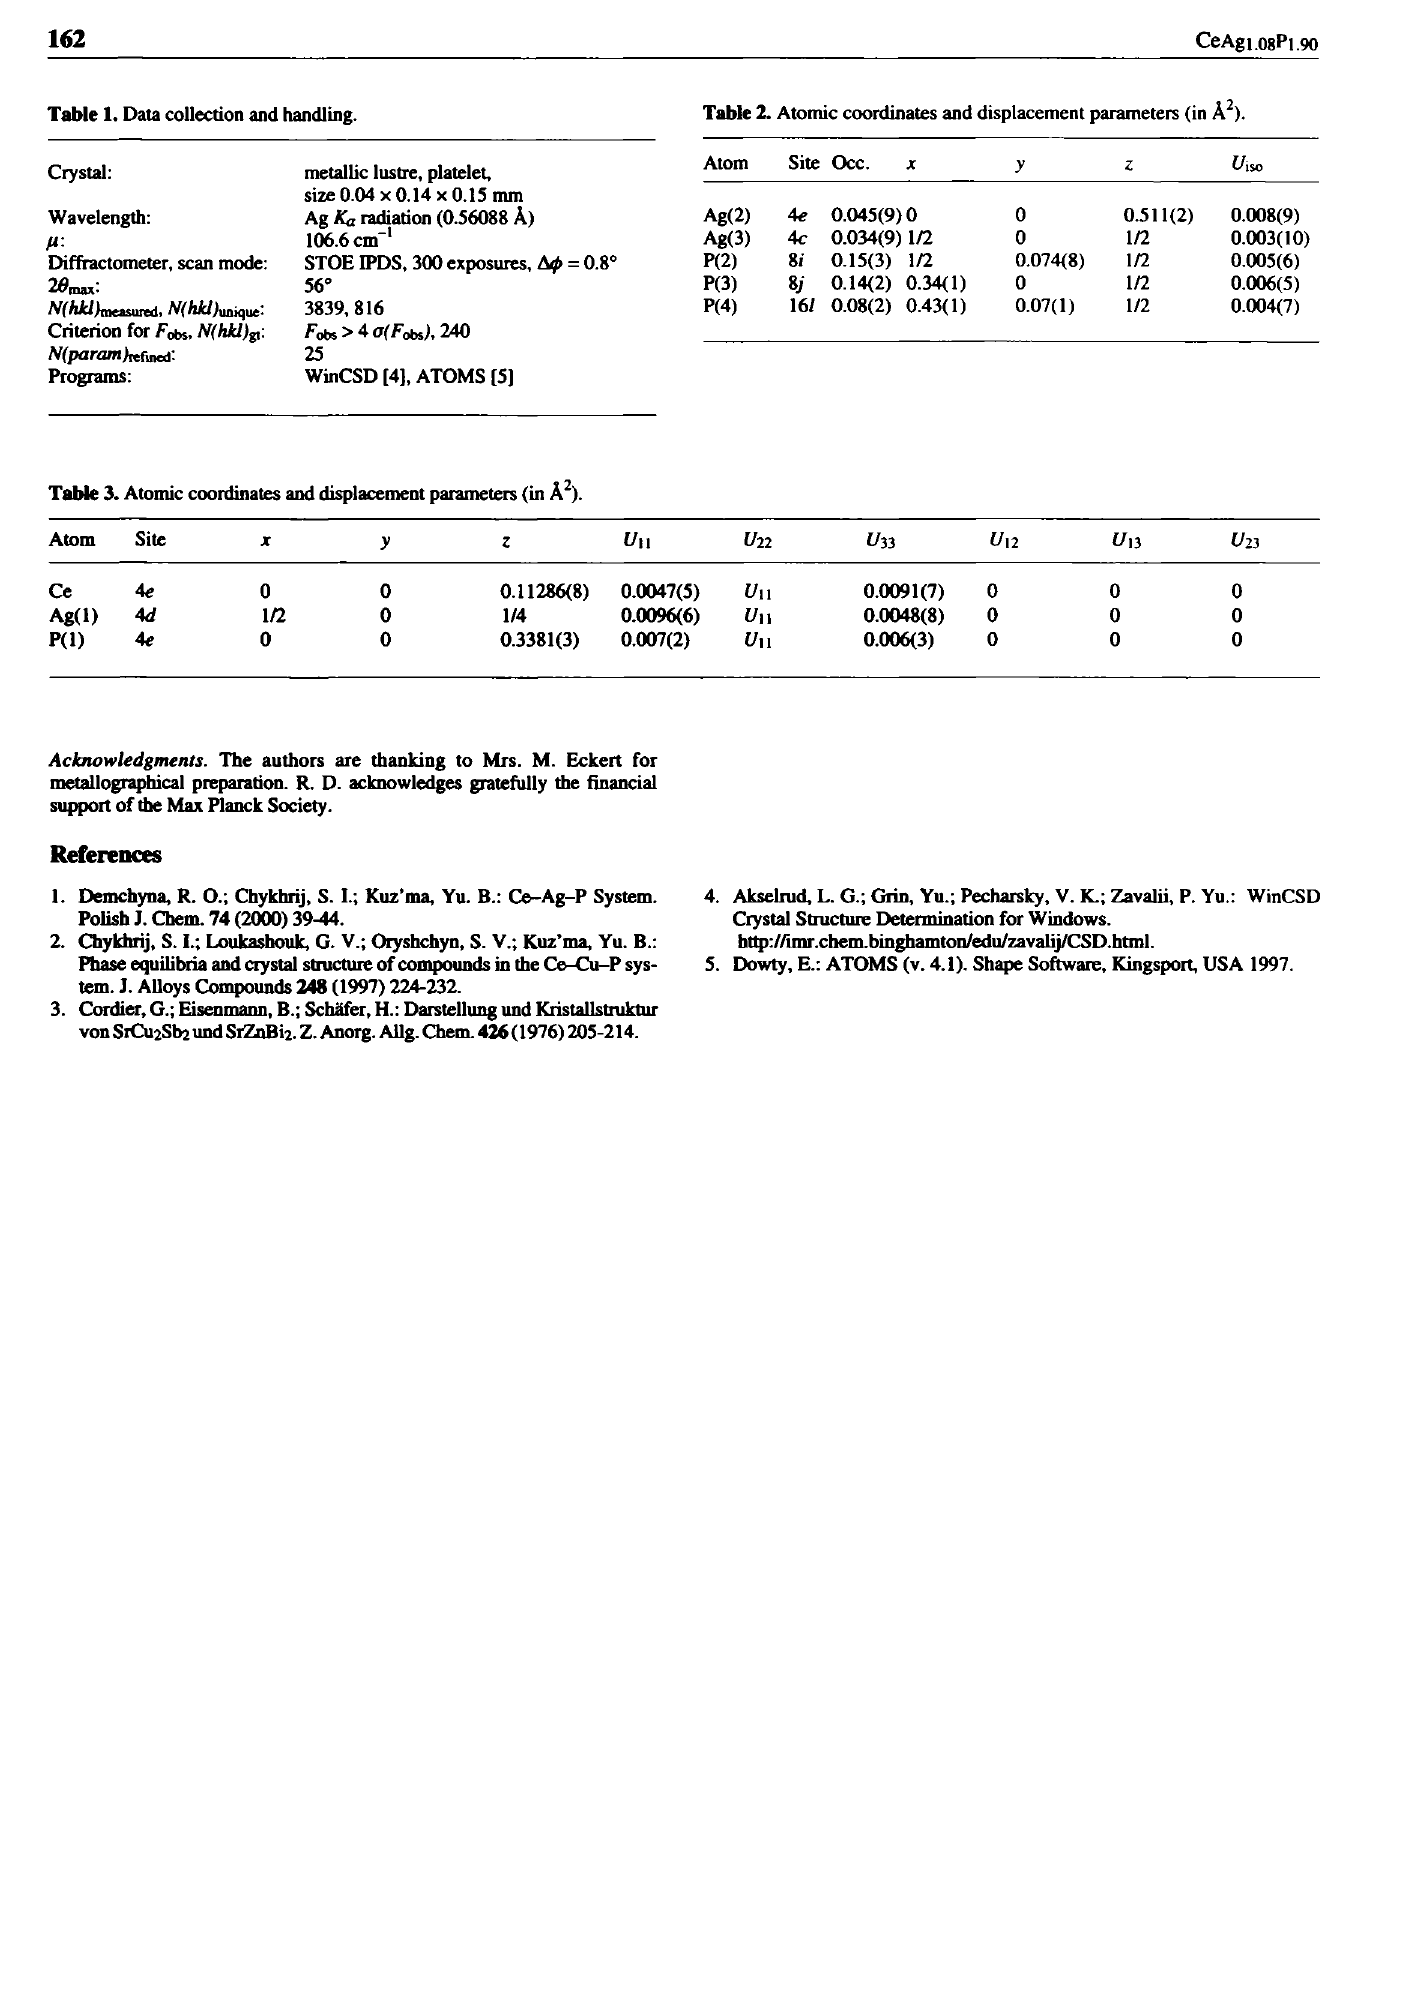
Table 1. Data collection and handling. Table 2. Atomic coordinates and displacement parameters (in Â 2 ).